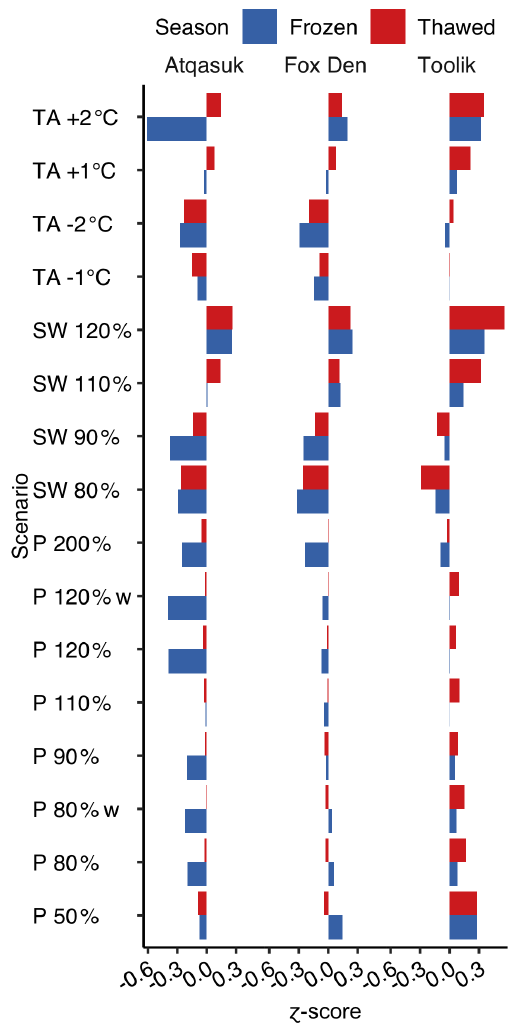
Figure 6. Model water temperature response (mean z -score, all wa- ter depths) across the three lakes, 16 scenarios, and two seasons (frozen and thawed, based on ice presence) as compared to the base- line scenario. Blue bars are the frozen season, and red bars are the thawed season. See Sect. 2 or Fig. 5 for a description of the scenar-